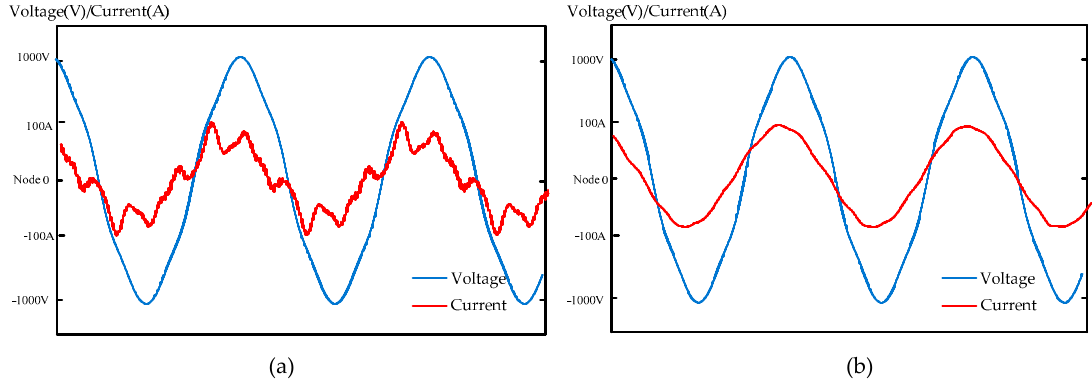
Figure 11. Voltage and Current at node zero: ( a )VI-APF off, and ( b )VI-APF on .